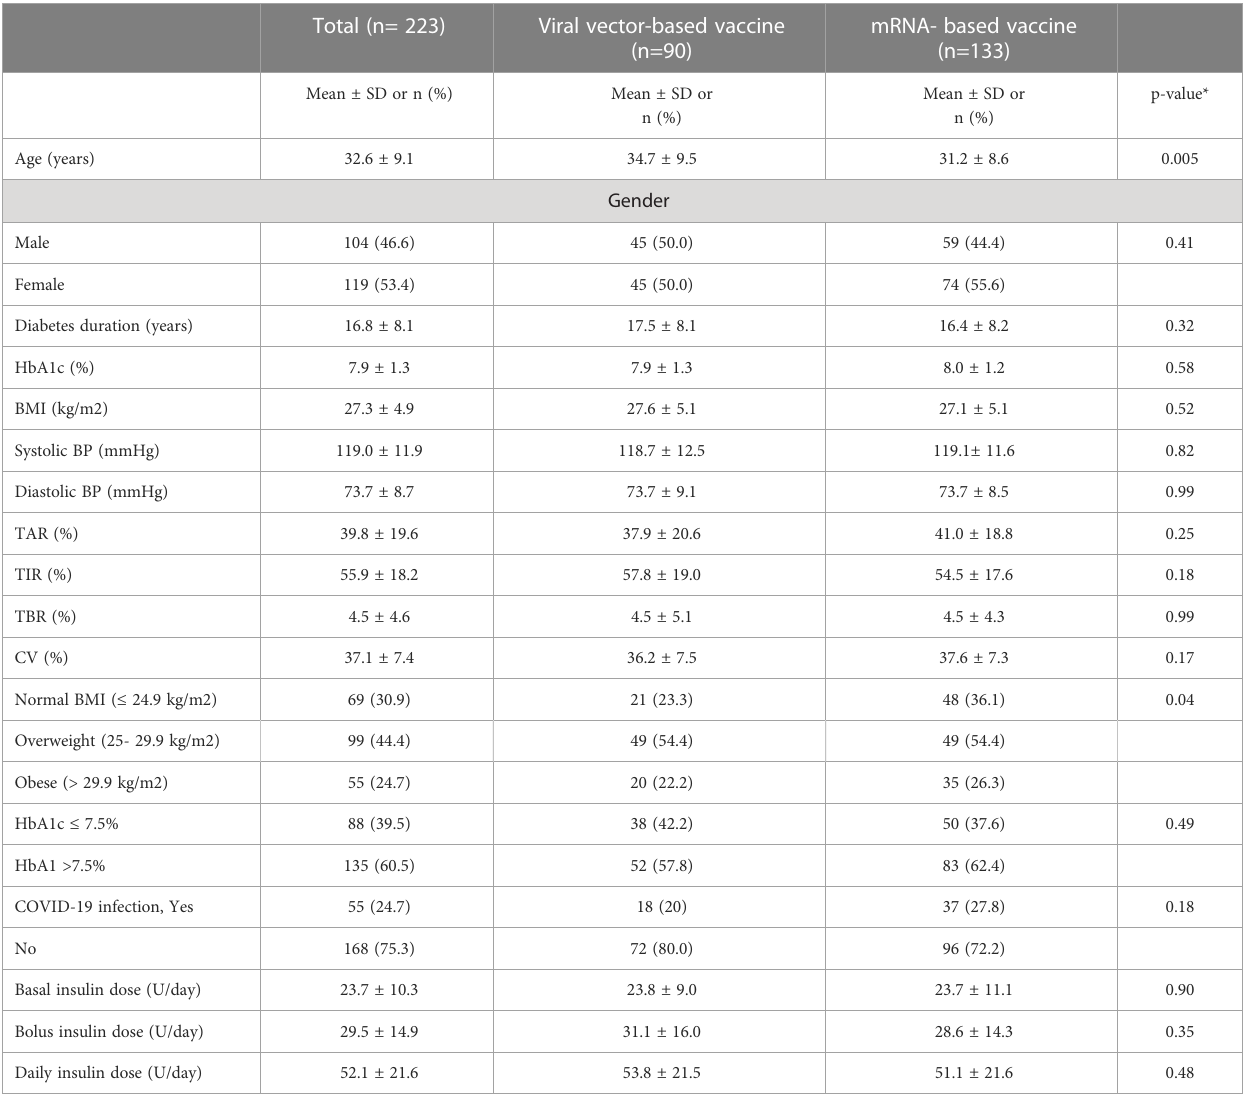
TABLE 1 Baseline information of the people with type 1